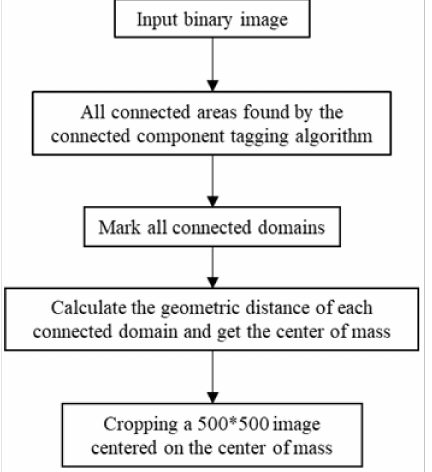
Figure 5. Algorithm flow for cropping the liquid map in the hole. The cropped liquid image in the hole is shown in Figure 6.